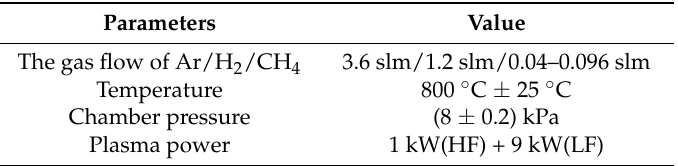
Figure 1. A diagram of the dual radio frequency inductively coupled plasma (RF-ICP) jet chemical vapor deposition (CVD) system used in this work. Table 1. Deposition parameters .